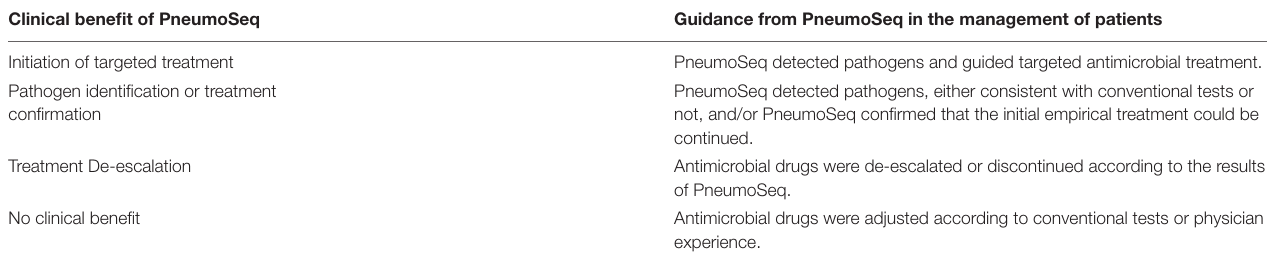
TABLE 3 | Guidelines for evaluating the clinical benefits of PneumoSeq. Clinical benefit of